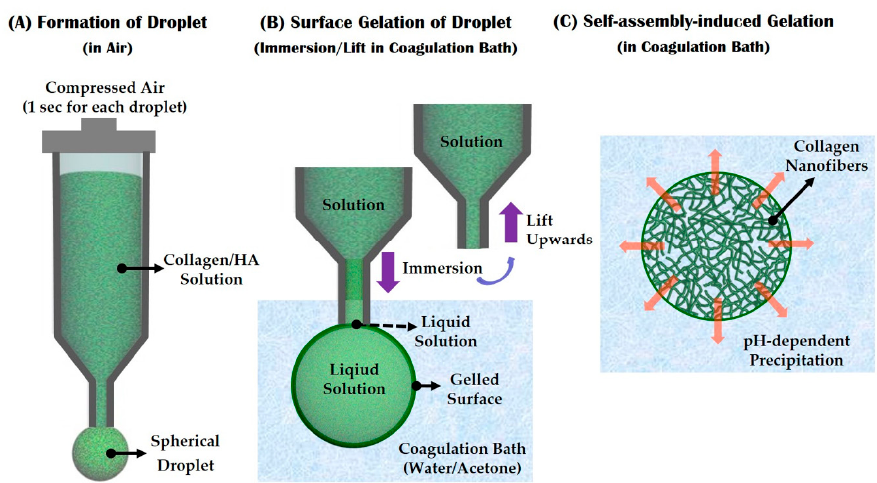
Figure 1. Schematic diagrams showing self-assembly-induced gelation technique for the synthesis of nanofibrous collagen/ hydroxyapatite (HA) composite microspheres: ( A ) The formation of a